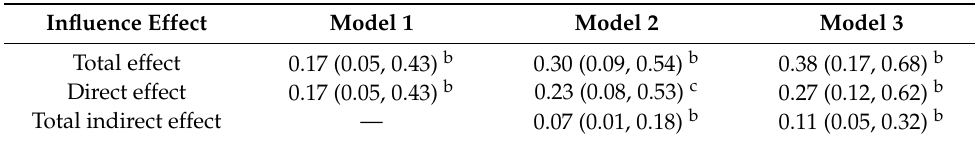
Table 10. Total, direct, and indirect associations of GSE with mental health in the structural equa- tion model.